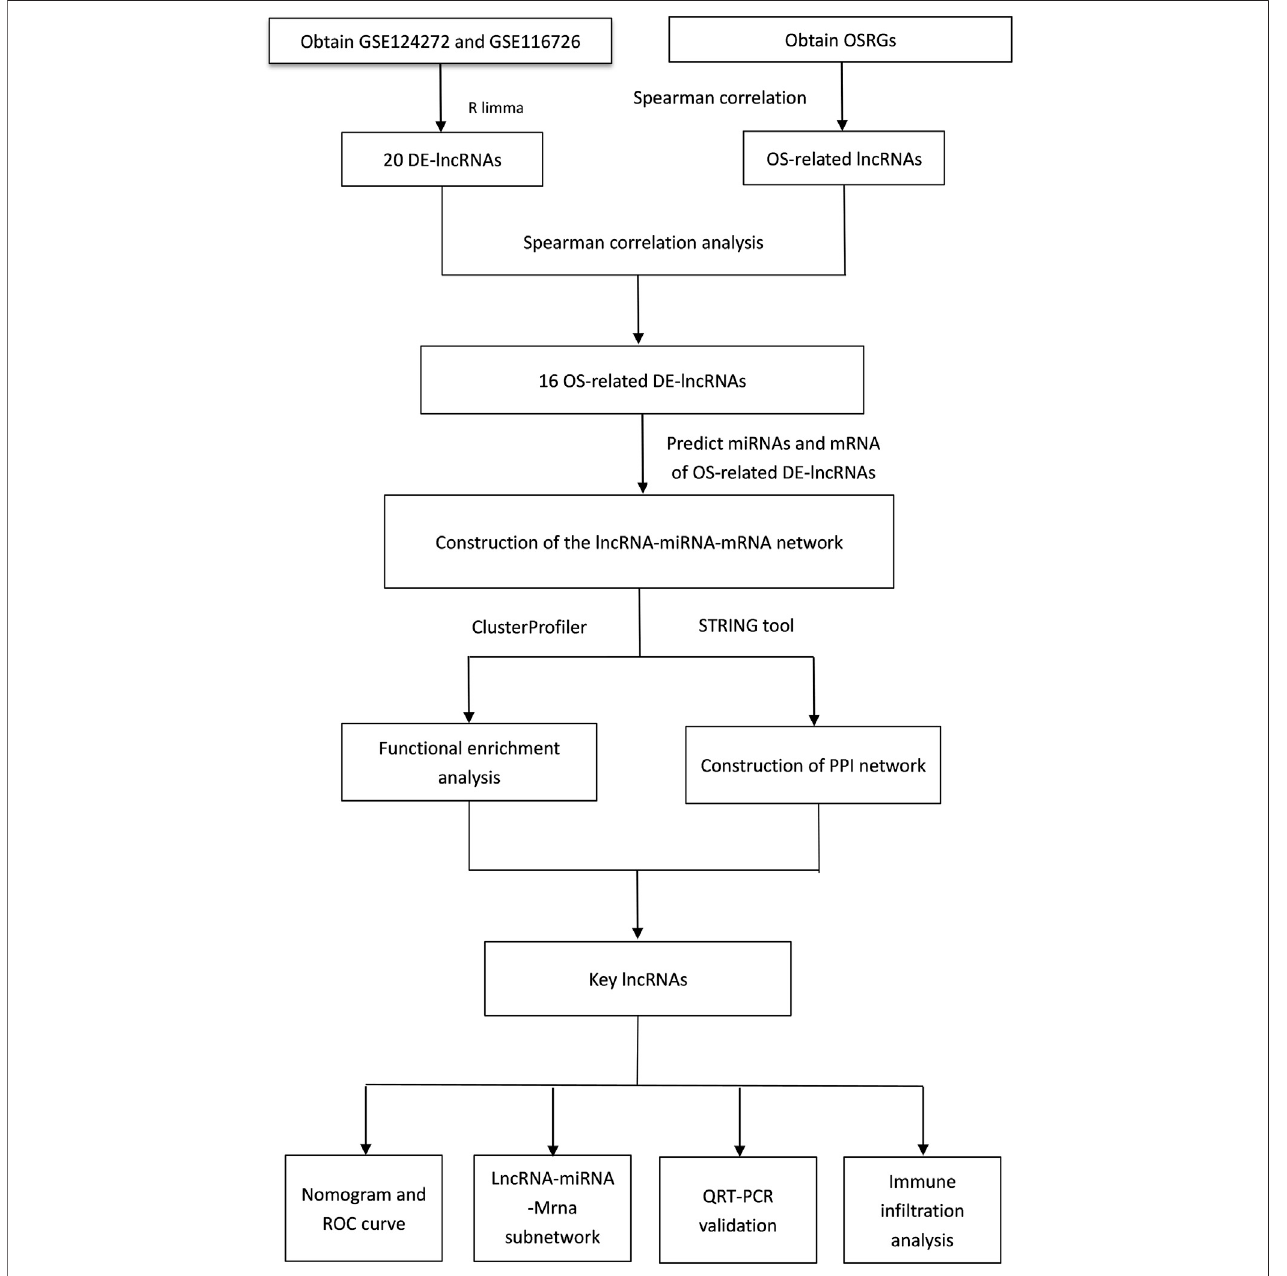
FIGURE 10 | Flowchart of key lncRNAs associated with oxidative stress were identi fi ed by GEO database data and whole blood analysis of intervertebral disc degeneration patients.